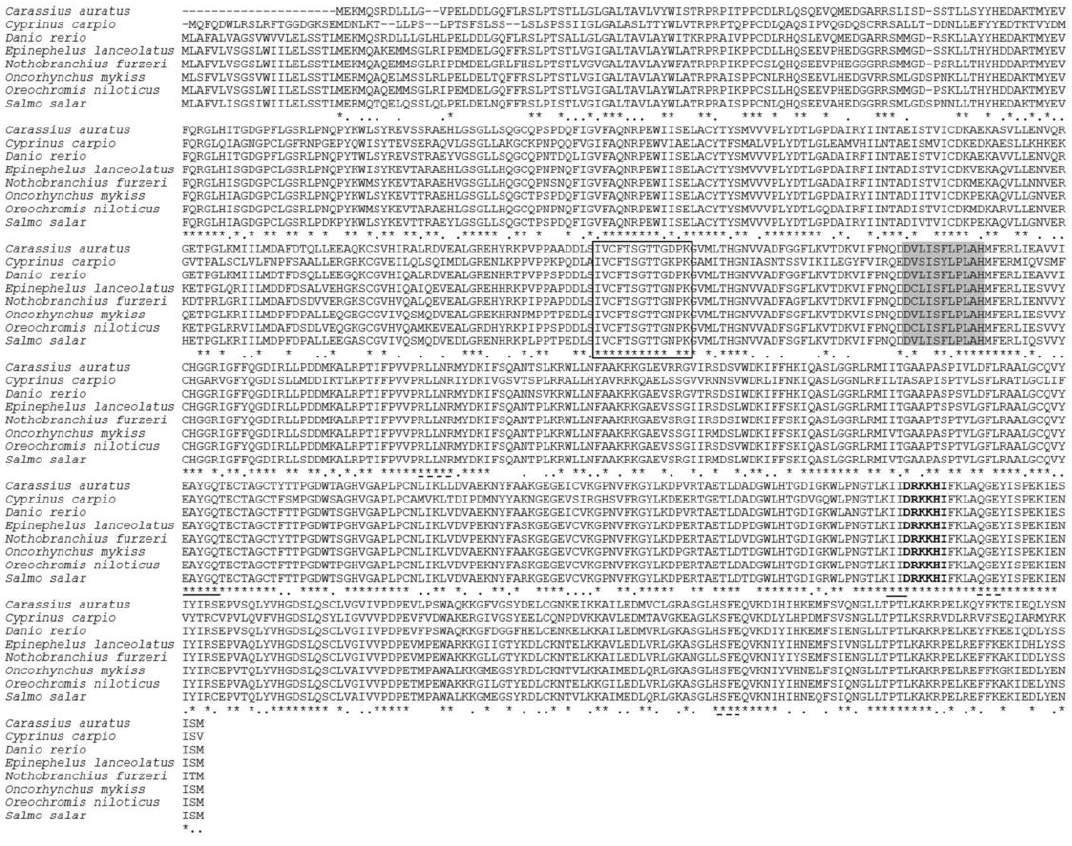
Figure 1. Alignment of the deduced amino acid (aa) sequences of acsl6 isolated from Cyprinus carpio with other orthologues, including Carassius auratus (XP_026089889.1), Danio rerio (XP_021324602.1), Epinephelus lanceolatus (XP_033505573.1), Nothobranchius furzeri (XP_015816936.1), Oncorhyncus mykiss (XP_021479764.1), Oreochromis niloticus (XP_003451433.2), and Salmo salar (XP_014053481.1): Deduced aa sequences were aligned using ClustalW2. Identical and similar residues are marked with * and :, respectively. The conserved acyl-activating enzyme (AAE) motif is a black box, the gate domain is shaded, two putative CoA binding sites are dash-underlined, the two putative AMP binding sites are solid underlined, and the linker domain is represented with bold.